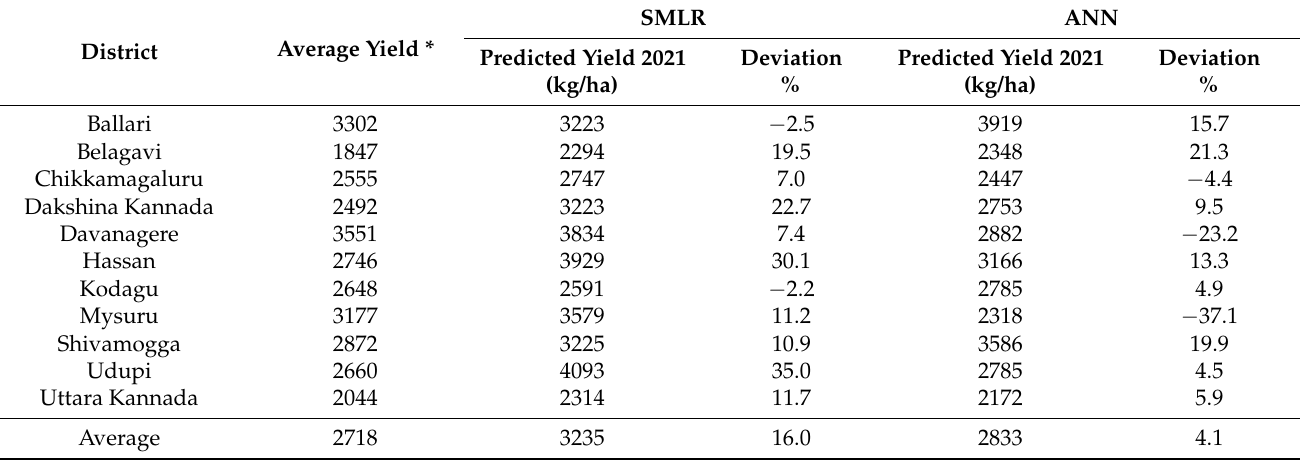
Table 10. District-wise average Kharif rice yield and predicted yields using a stepwise multiple linear regression and an artificial neural network (ANN) during 2021 at the preharvest (F3)